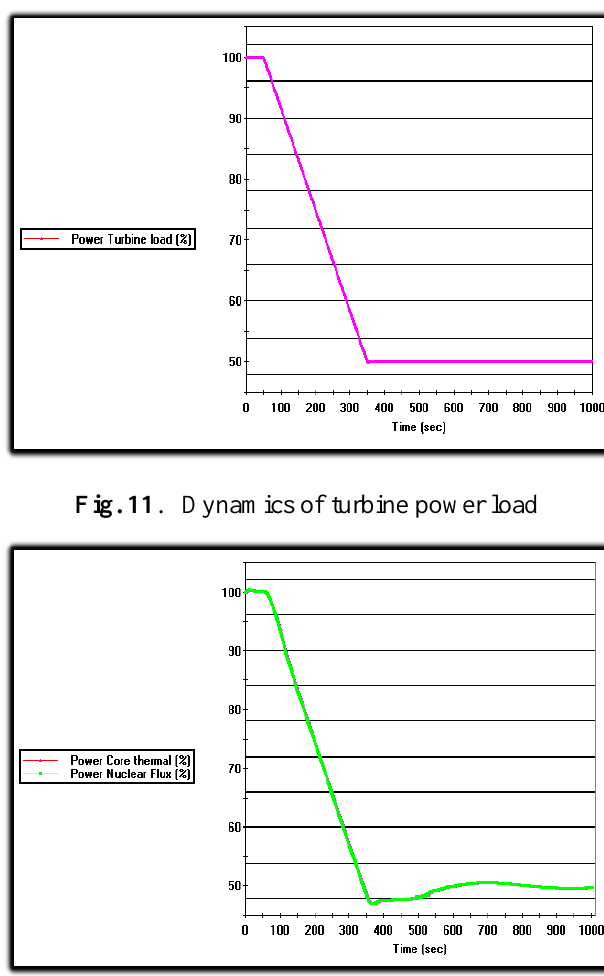
Fig. 12 . Dynamics of reactor